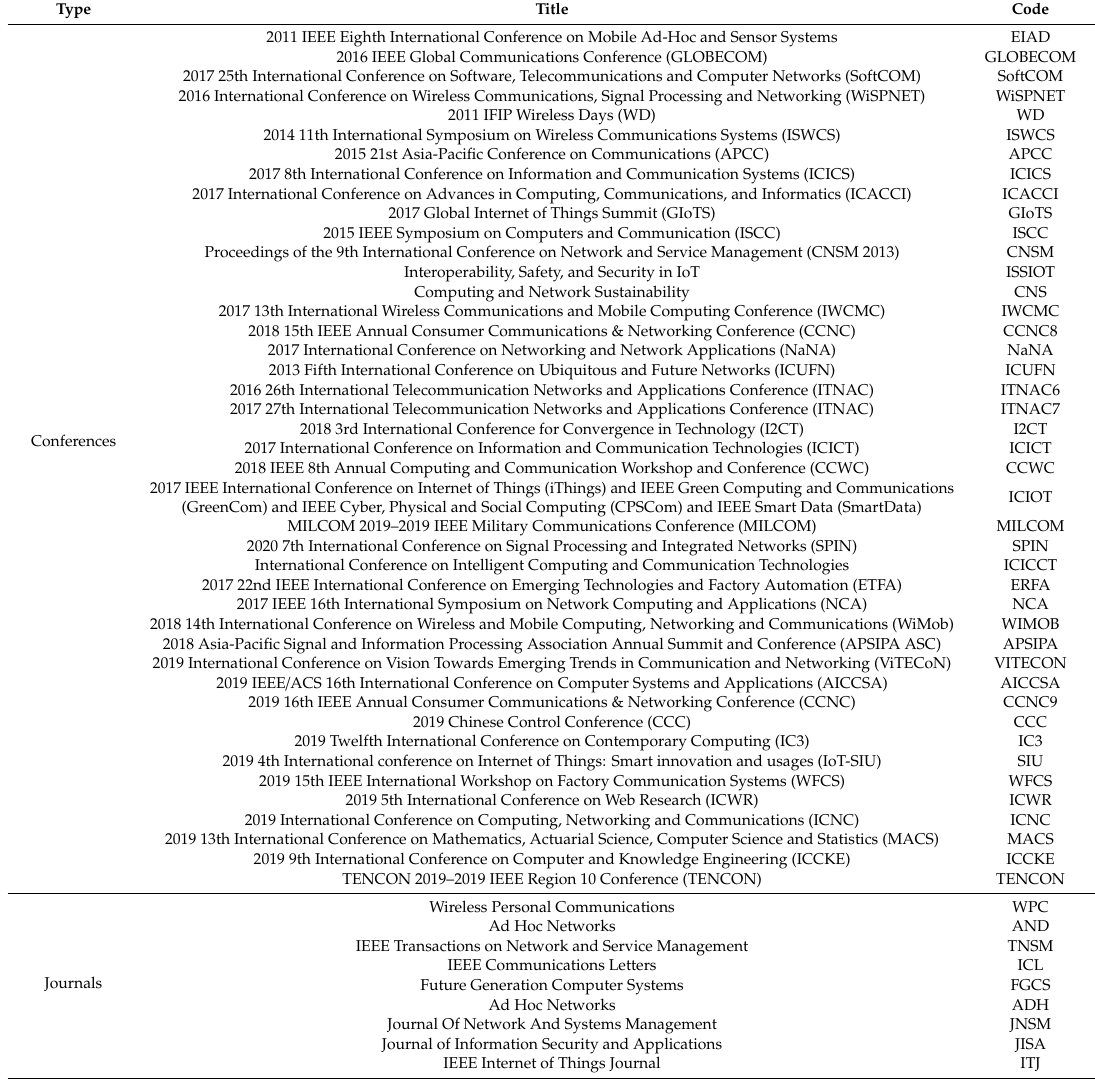
Table 3. Conferences, journals and books coding.